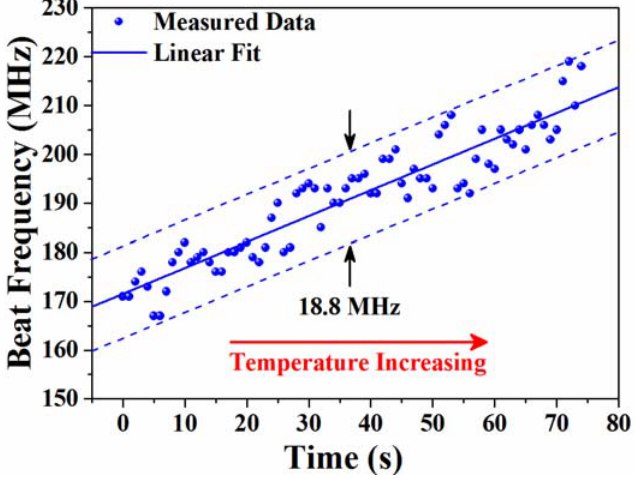
Figure 7. Beat-frequency stability of the heterodyne spectrum.